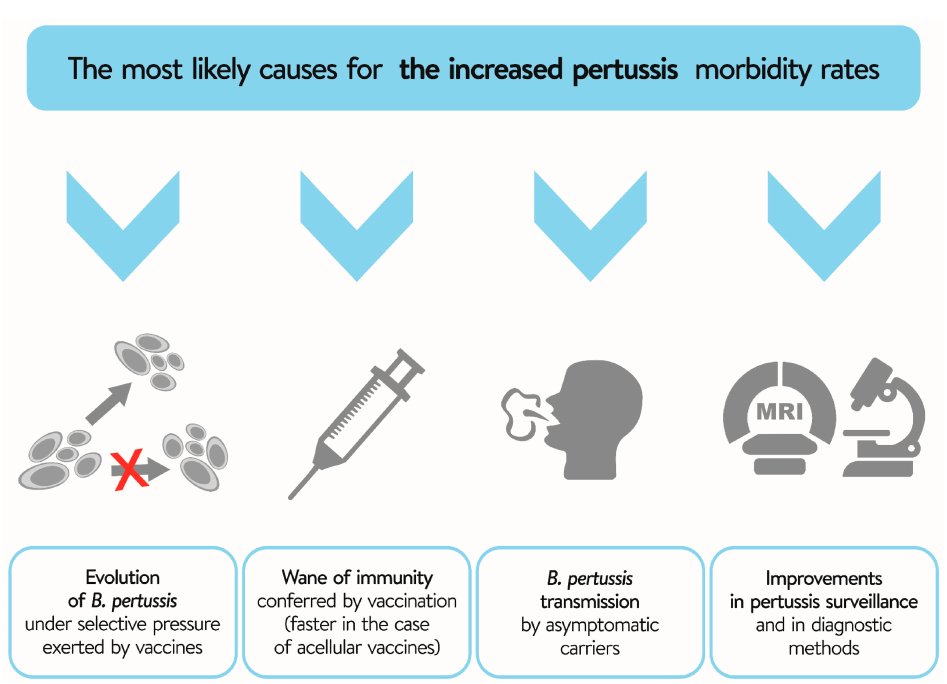
Figure 1. Plausible causes of the increased incidence of whooping cough in the last decades.